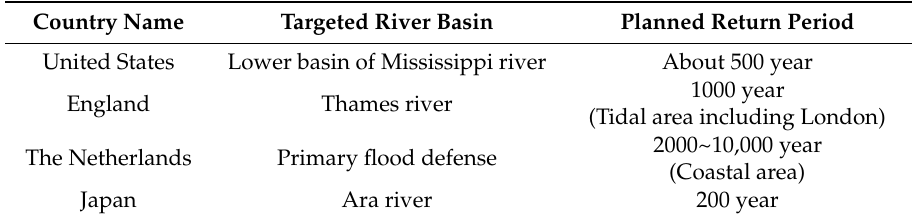
Figure 1. Observed data for annual maximum daily precipitation for 36 years at Ikari observatory in the Tone river basin, with a Gumbel distribution fitted to these observed data and an observed datum for a heavy rainfall event in 2015. Table 1. Design return periods in major river basins of various countries.